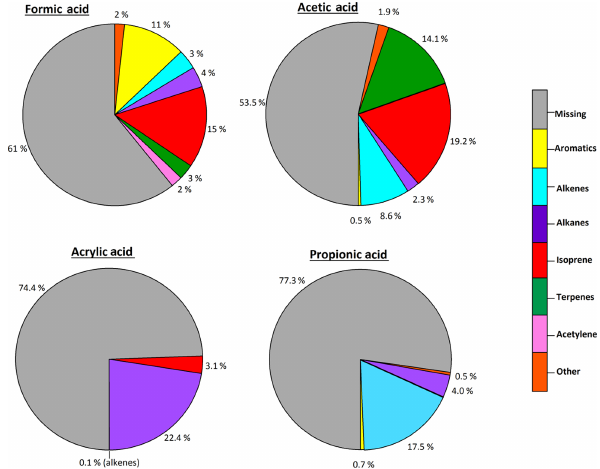
Figure 9. Relative contribution of various precursor hydrocarbon types in the photochemical box model to the modelled secondary production rate after 3h of evolution during F19, for formic, acetic, acrylic, and propionic